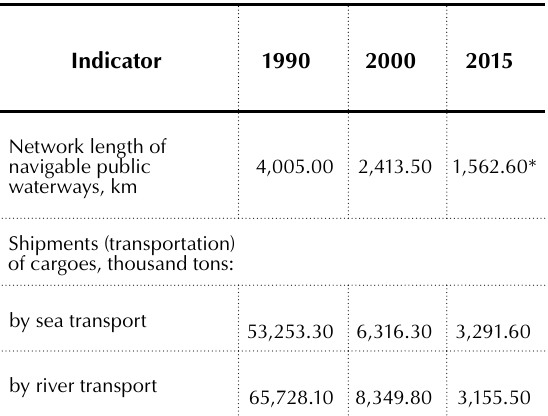
Table 1. Characteristics of the river transport